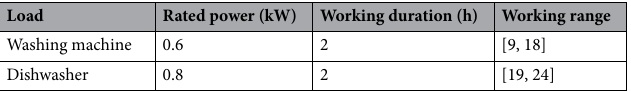
Table 1. The parameters of shiftable but uninterruptible